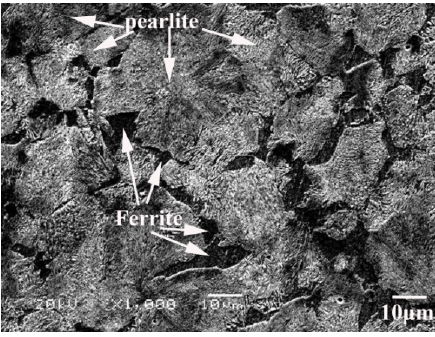
Figure 6. Microstructure of hot ‐ rolled and annealed 40Cr steel.